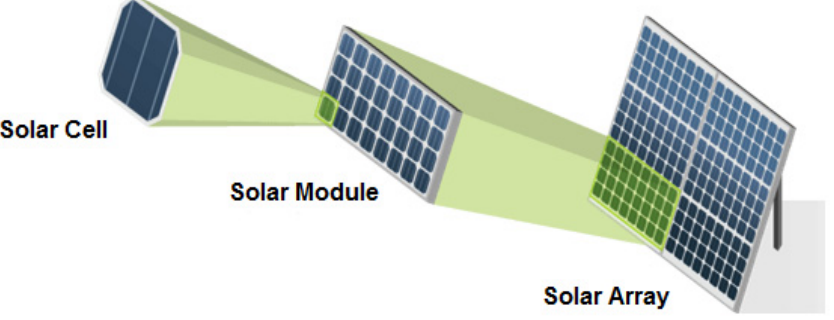
Figure 2. From solar cell to